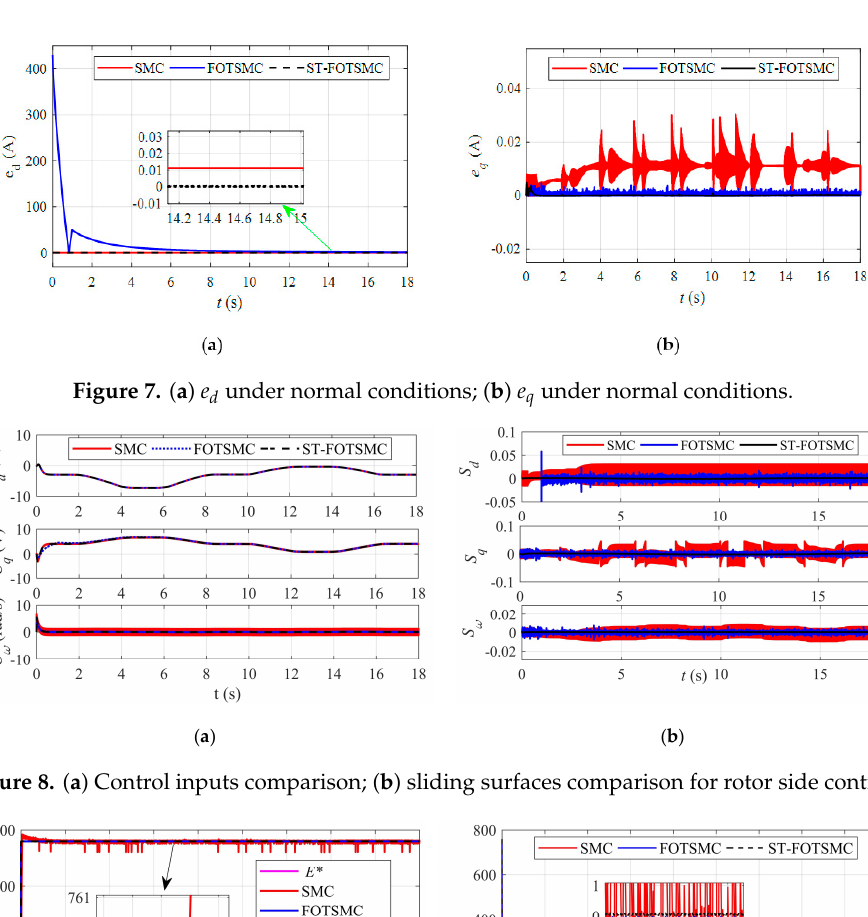
Figure 8. ( a ) Control inputs comparison; ( b ) sliding surfaces comparison for rotor side control.